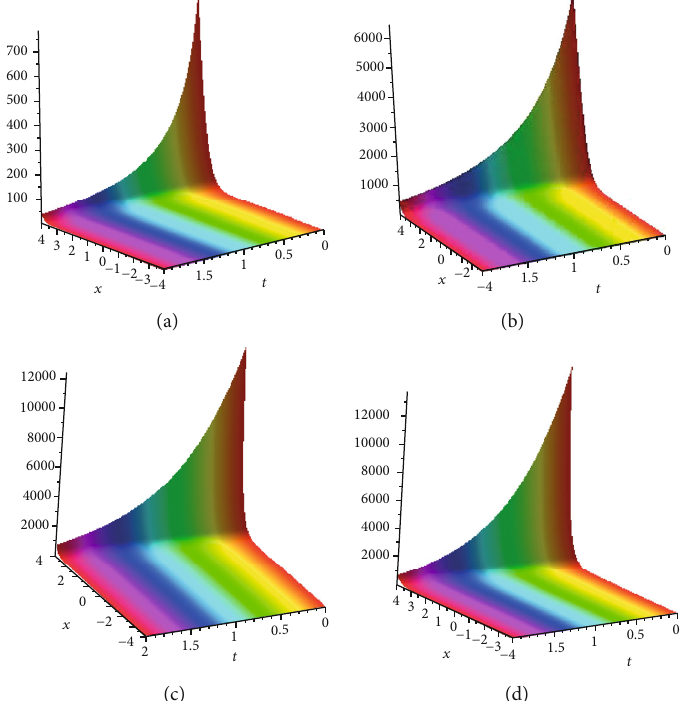
= 1 : 5 , q = 0 : 2 , r = 2 , λ = 2 : 2 , M = − 3 , N = 2 , and k = 3 when (a) α = 0 : 25 , (b) α = 0 : 5 , (c) 1 2 1